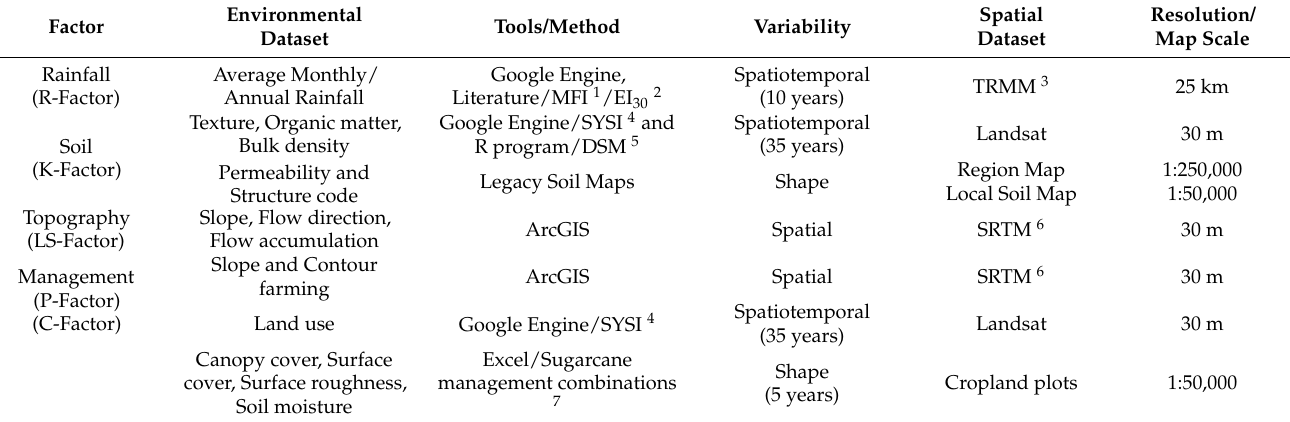
Table 1. Synthesis of the RUSLE spatial dataset required to map soil loss by water